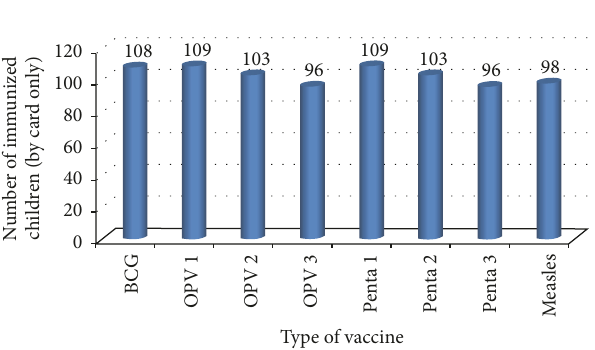
Figure 2: Immunization status of children aged 12–23 months by card plus mothers recall at Mizan Aman town, Bench Maji zone, Southwest Ethiopia,